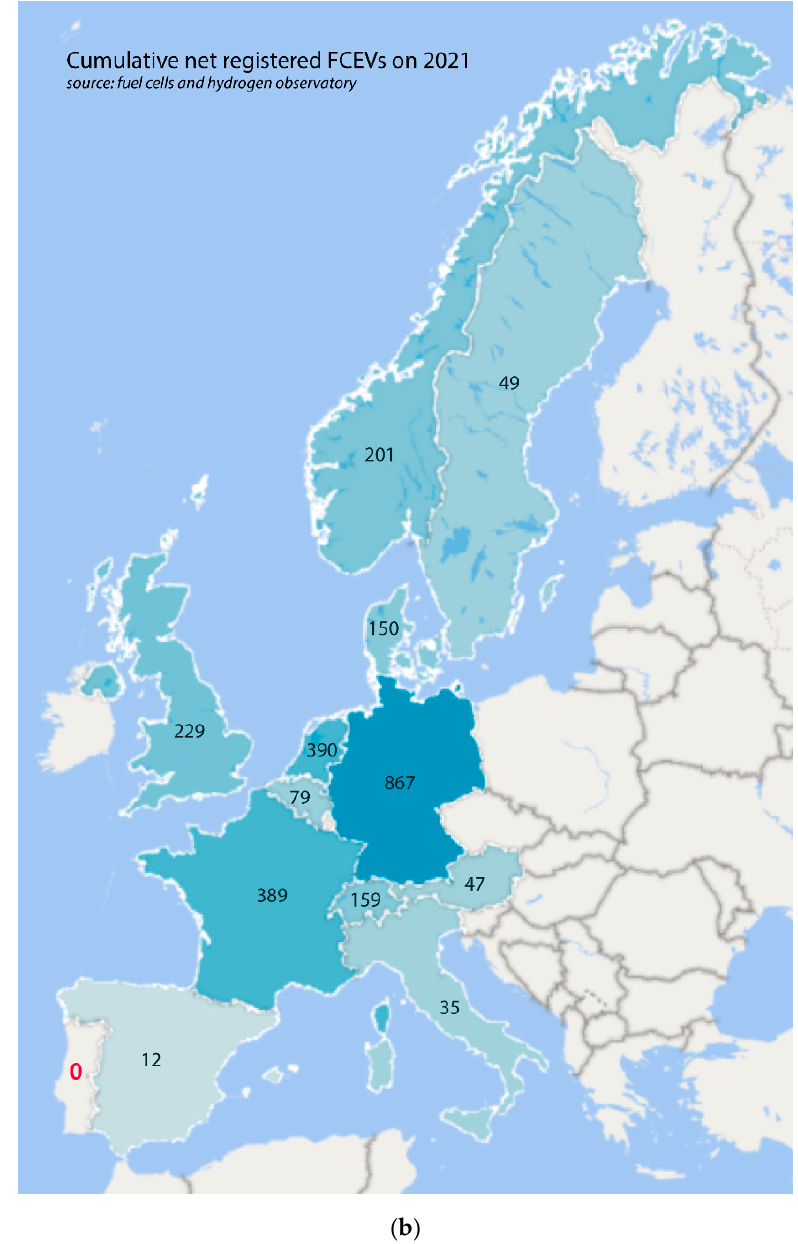
Figure 1. ( a , b ) Cumulative Net registration FCEVs in Europe (data source: fchobservatory) [4].